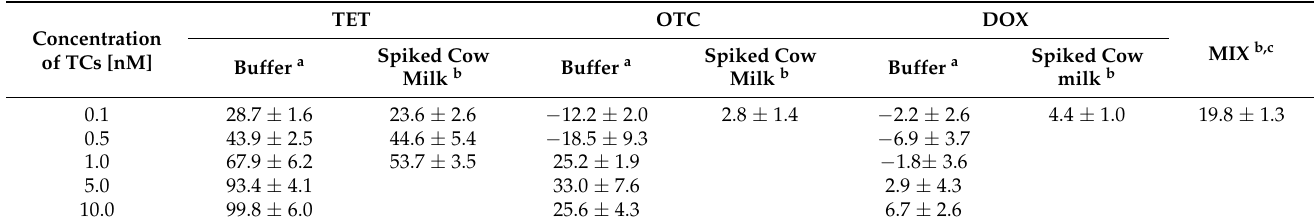
Table 2. The values of relative intensity of current ∆ I [%] measured with electrodes modified with the HS-Apt-Fc/MCH layer after incubation with TET, OTC, and